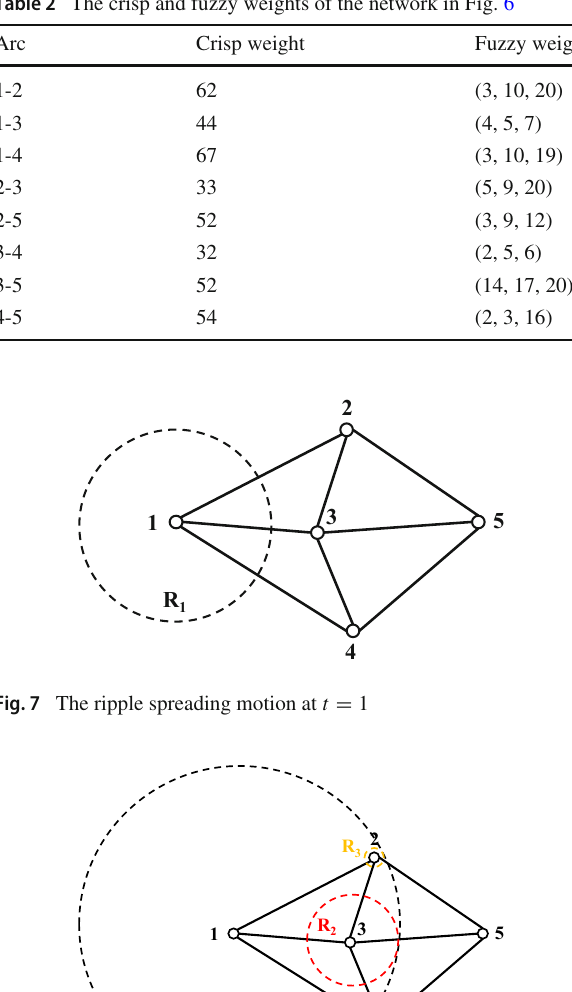
At t = 2, R 1 reaches node 3 and triggers a new ripple R 2 (red, radius = 20). R 1 reaches node 2 and triggers a new ripple R 3 (yellow, radius = 2), as shown in Fig. 8. has visited all nodes connected to node 1, and we eliminate